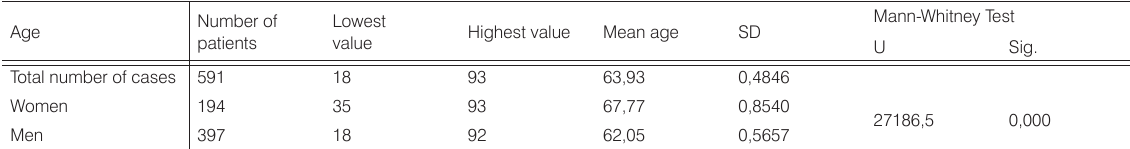
Table 1. Sex and age of AMI hospitalized patients in the period between 01.10.2004 and